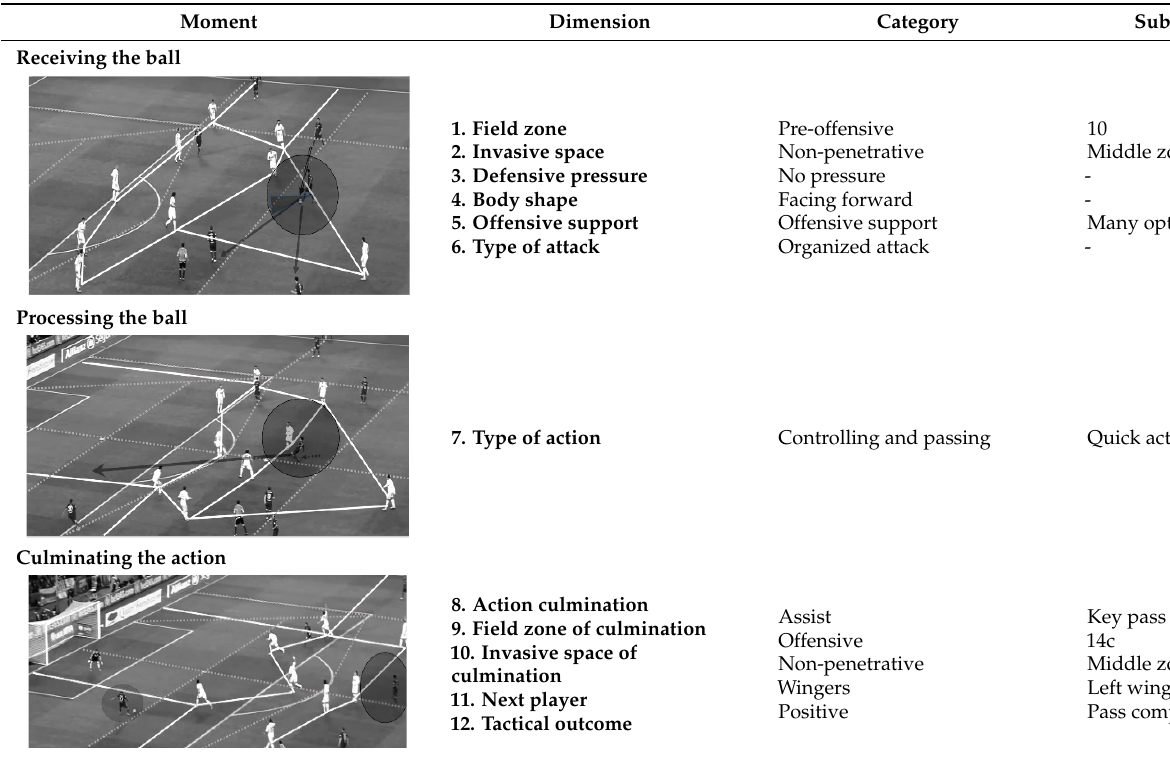
Table 4. Example of analysis of the IBP using the dimensions of the INDISOC tool.